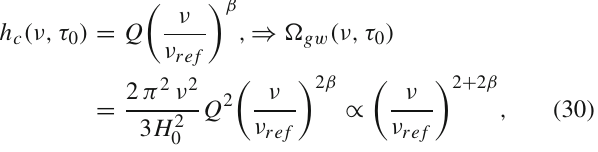
Fig. 2 Theallowedregionoftheparameterspaceisillustratedtogether with the explicit form of the spectral energy density when the corre- sponding parameters are selected within the shaded region where all the relevant are satisfied. The different contours appearing in the plot at the left correspond to the values of h 2 approximately denotes most sensitive frequency domain of the wide- band interferometers (i.e. Kagra-LIGO-Virgo) that recently provided